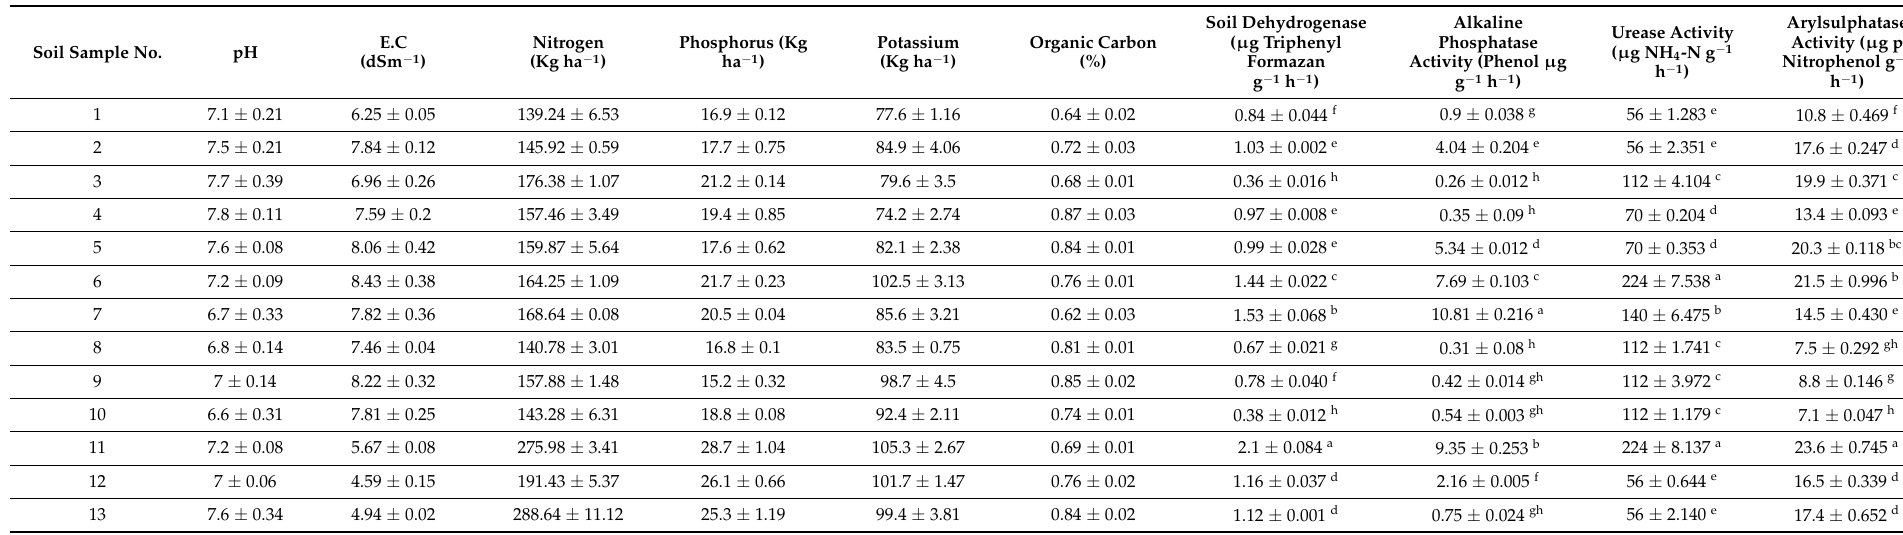
Values in each column are the mean of three replications ± SE (standard error). Mean values in each column followed by the same letter(s) are not significantly different at 5%